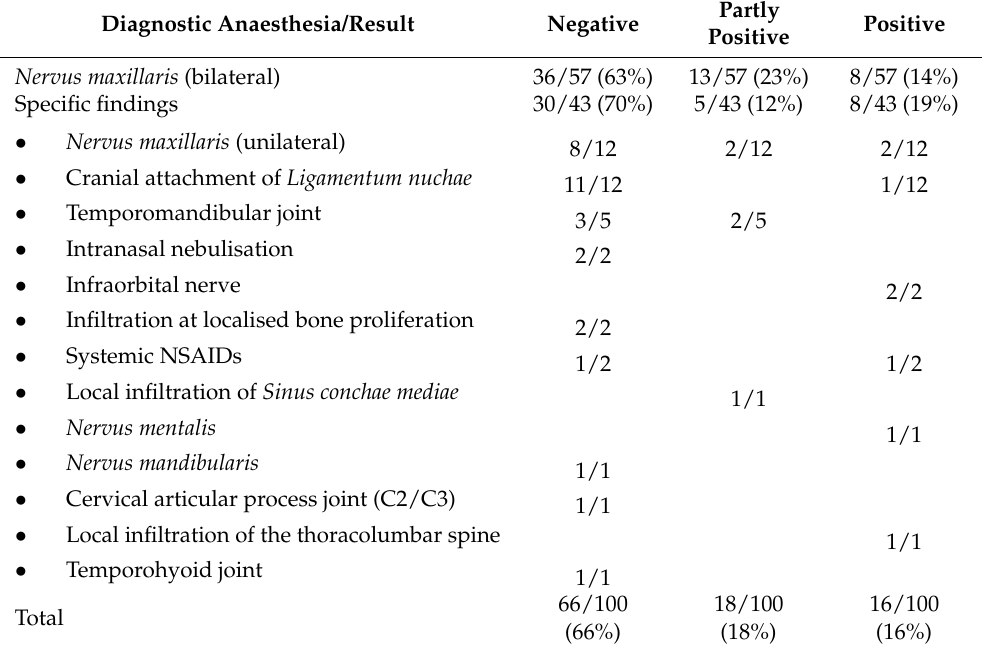
Table 3. Results of different diagnostic anaesthesia procedures. Relative (%) and absolute abundance (n) of response are shown for different kinds of diagnostic anaesthesia. Relative abundance (%) (n),